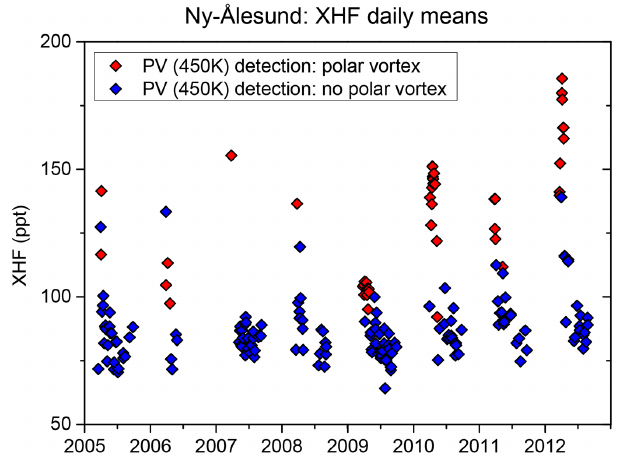
Figure D1. XHF daily mean time series for Ny-Ålesund obtained from NIR measurements (TCCON). Polar vortex days were de- tected by using the PV criterion by Nash et al. (1996).